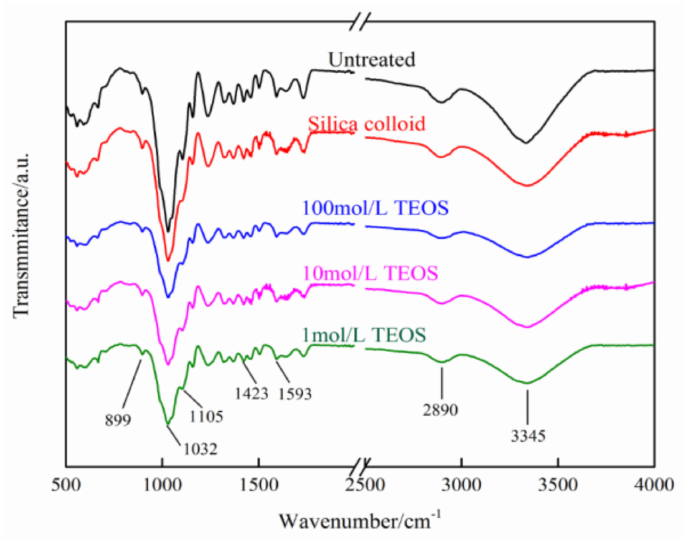
Figure 6. FTIR images of the poplar cross section under different treatment